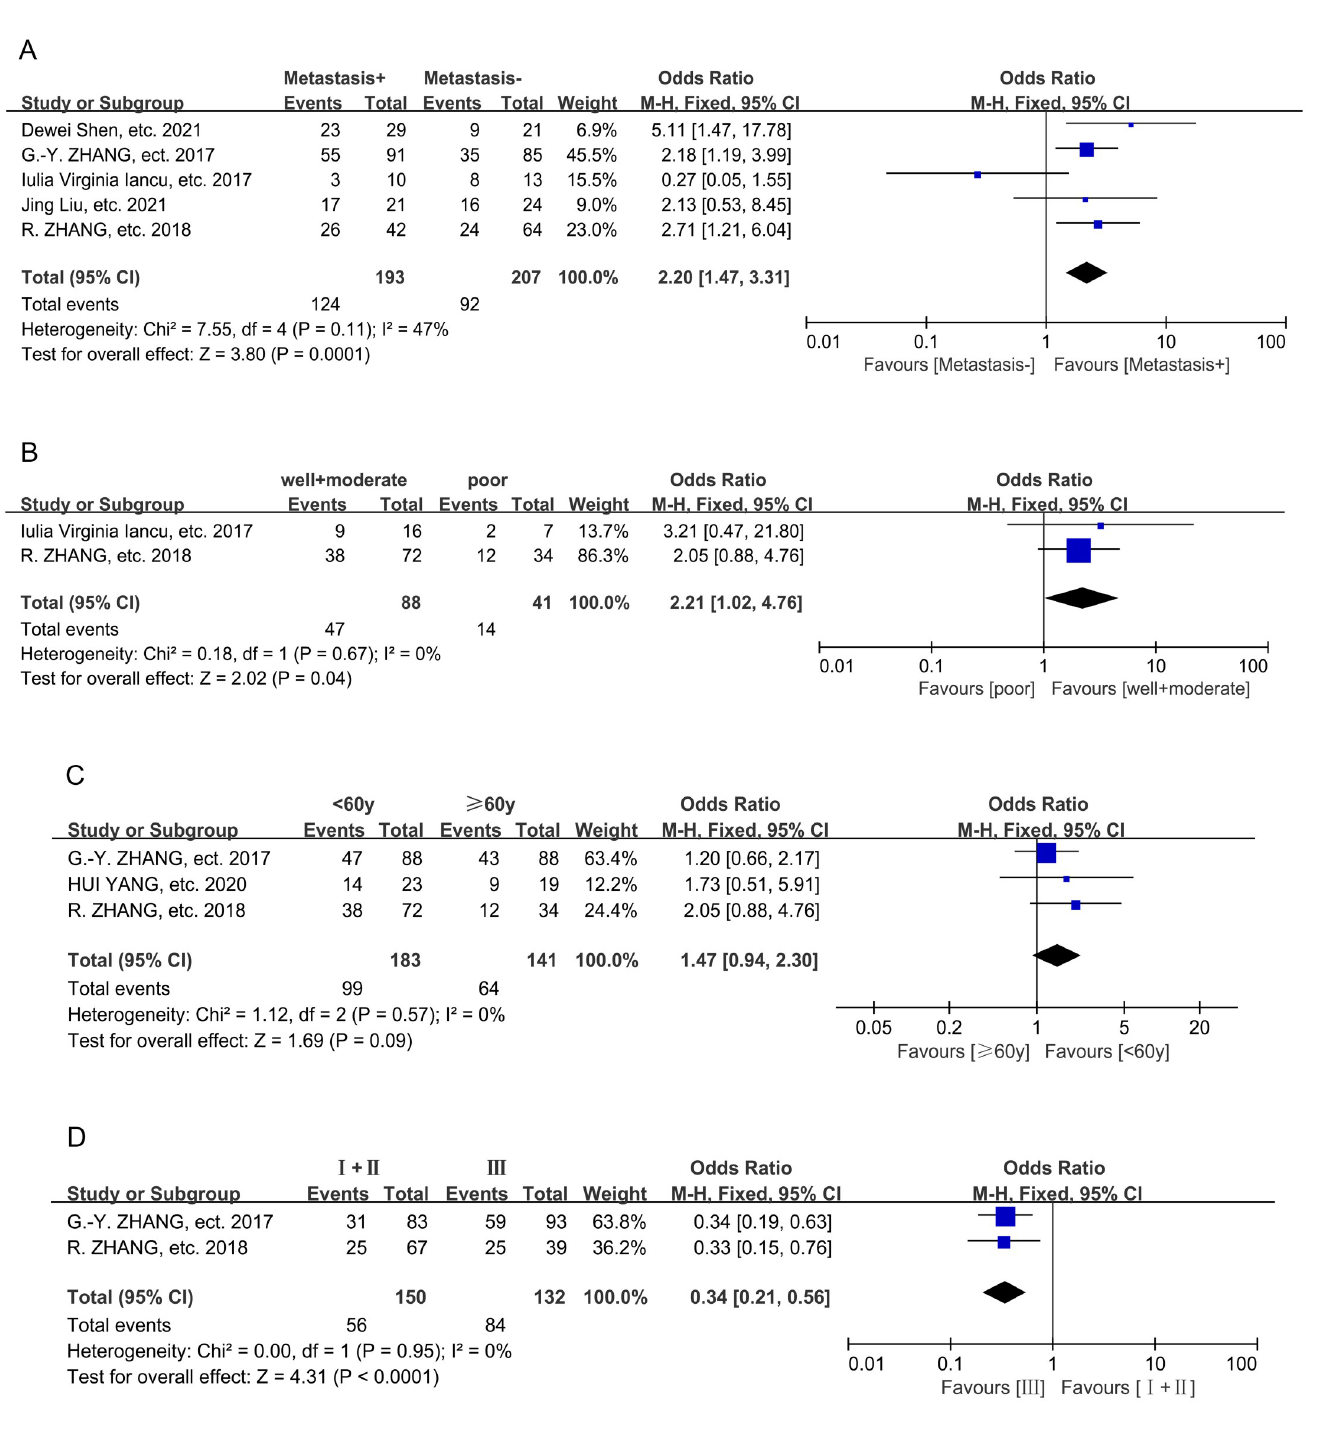
Fig 3. Forest plots for the association of EWSAT1 expression with several clinicopathological features. (A) Forest plots for the association of EWSAT1 expression with cancer metastasis, (B) differentiation, (C) age, (D) TNM